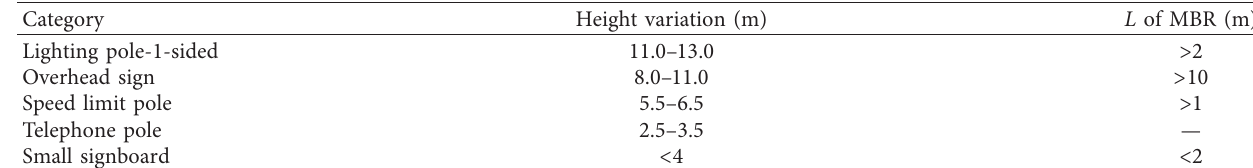
Table 4: Parameter settings for PLO classification at Site 1.